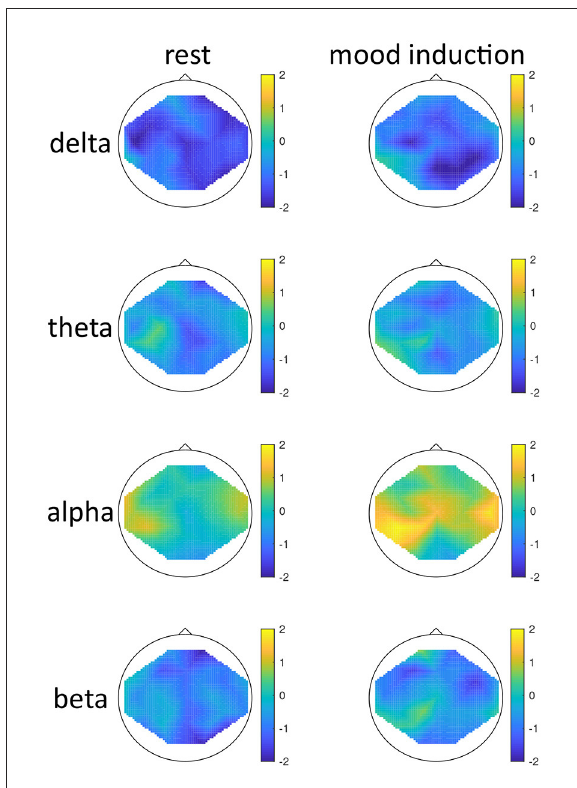
FIGURE2 Topographical maps of activity distribution: colors represent difference between participants with low and high global seasonality score, indicated by approximated z -values from a Wilcoxon rank sum test, for frequency ranges from top to bottom : delta, theta, alpha, beta; and for conditions rest (left) and after mood induction, during the free-thinking period (right) . Negative z -values indicate lower activity in the low- compared to high-seasonality group, positive z -values indicate higher activity in the low- compared to high-seasonality group.